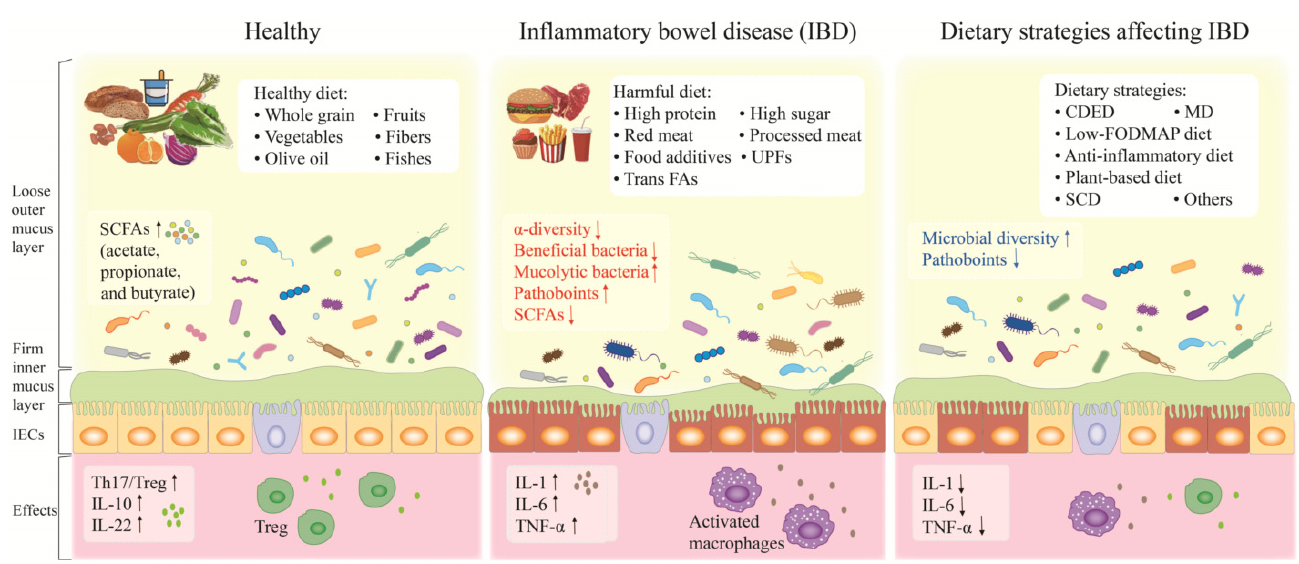
Figure 1. The role of diet in the pathogenesis and remission of inflammatory. Studies have demon- strated that the Westernized diet and certain dietary components alter the gut microbiota, intestinal mucosal layer as well as mucosal immunity, which are associated with initiation of IBD. In contrast, some food composition and dietary patterns protect or improve intestinal microbiota and result in IBD remission. ↑ represents an increase, ↓ represents a decrease. Abbreviations: IECs, intestinal epithelial cells; PUFAs, poly-unsaturated fatty acids; SCFA, short chain fatty acids; UPFs, ultra-processed foods; FAs, fatty acids; CDED, Crohn’s disease exclusion diet; MD, Mediterranean diet; FODMAP, fermentable oligo-, di-, mono-saccharides and polyols; SCD, specific carbohydrate diet.